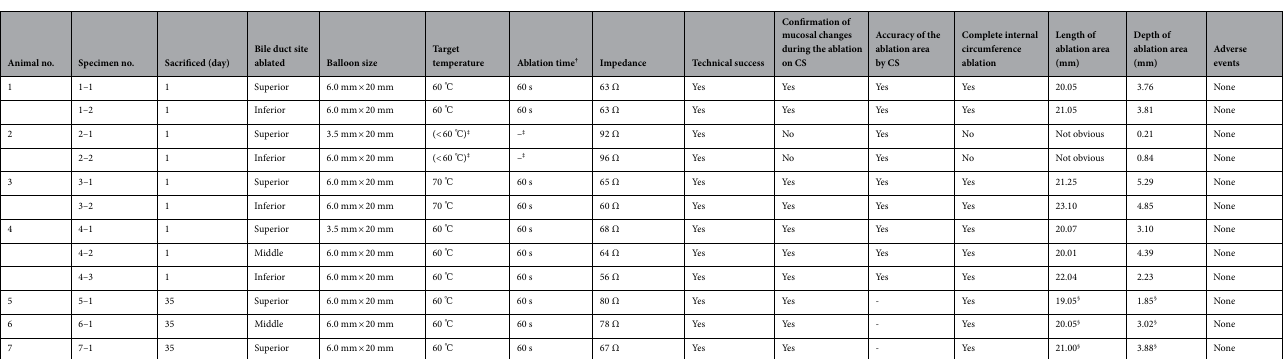
Table 1. Findings of cholangioscopy-guided balloon-based endobiliary radiofrequency ablation in an animal model. CS cholangioscopy. † Time for which the target temperature was maintained. ‡ Did not reach the target temperature due to the thickness of the bile ducts and poor contact of the electrodes with the bile duct wall. § These are the areas of granulation tissue rather than the ablation (coagulative necrosis) area.